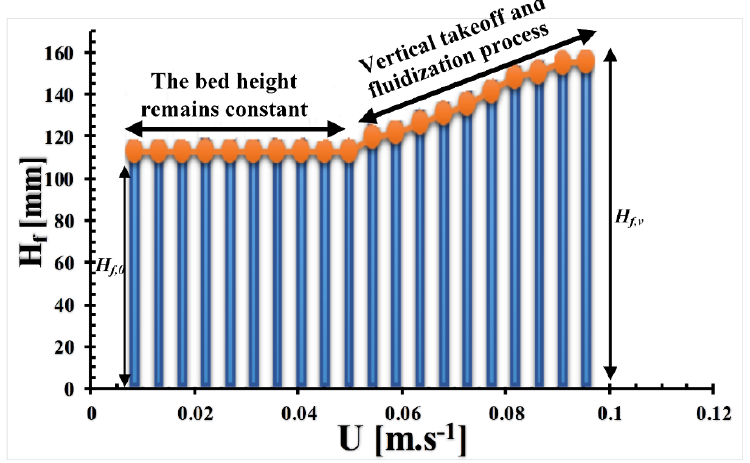
Figure 9. Evolution of maximum fluidized bed height H f as a function of the fluidization rate U.